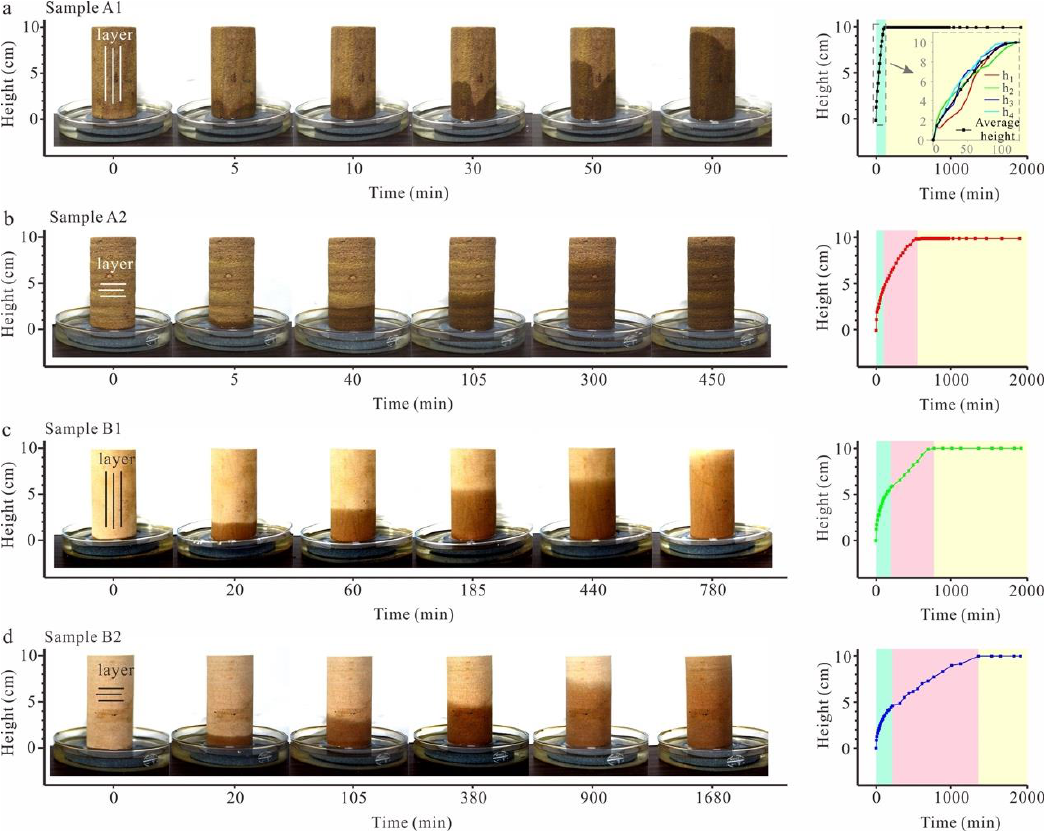
Figure 3. Water-absorption heights with time in ( a ) Sample A1; ( b ) Sample A2; ( c ) Sample B1 and ( d ) Sample B2.